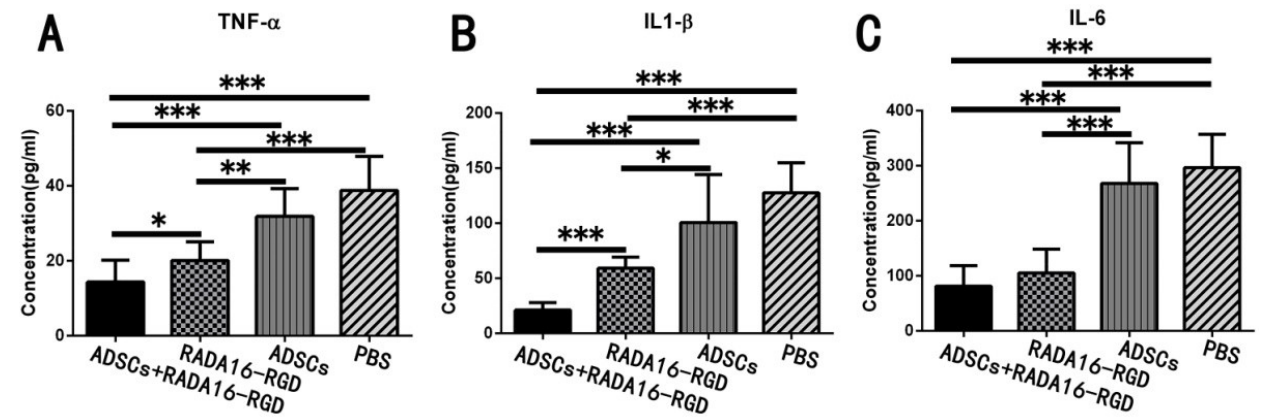
Figure 9. ADSCs+RADA16-RGD transplantation inhibits the expression of inflammatory factors. The spinal cord samples were collected from rats 2 weeks after ADSCs+RADA16-RGD transplantation to detect the expression of inflammatory cytokines TNF-α, IL-1β, and IL-6. ( A ) The expression of TNF-α was significantly lower in the ADSCs+RADA16-RGD group than in the PBS, ADSCs, and RADA16-RGD groups (ADSCs+RADA16-RGD vs. RADA16-RGD: p < 0.05, ADSCs+RADA16-RGD